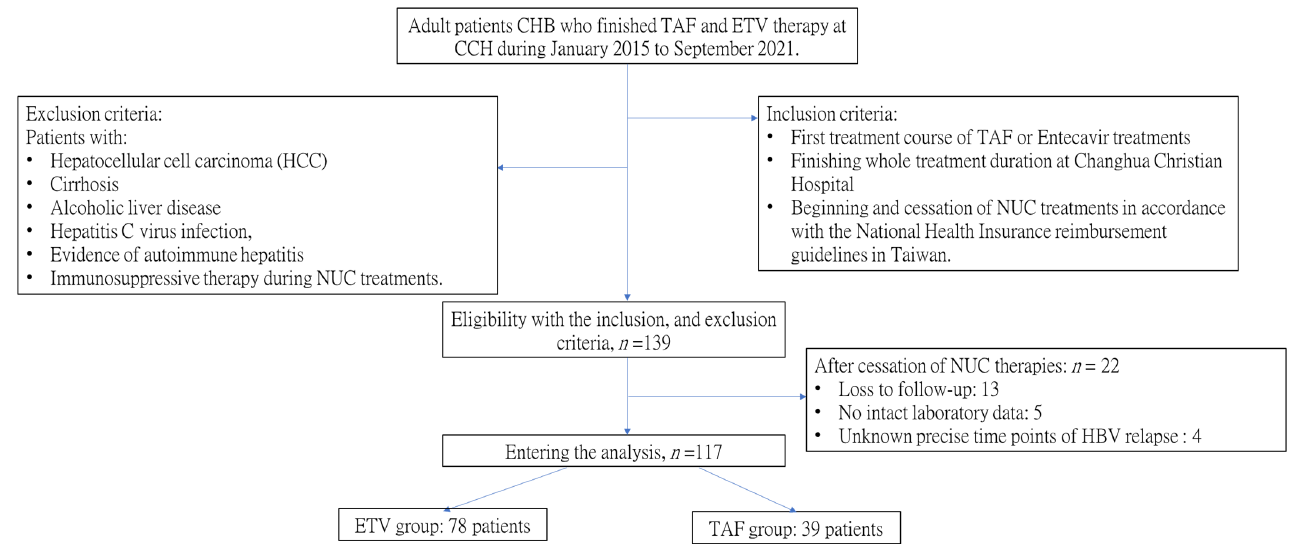
Figure 1. P atient disposition during the study. CHB, chronic hepatitis B; TAF, tenofovir alafenamide; ETV, entecavir; CCH, Changhua Christian Hospital.